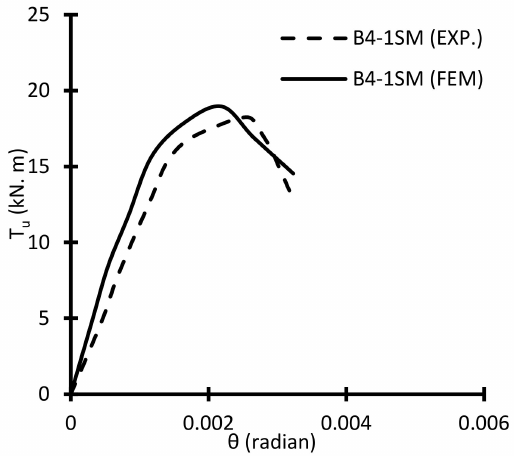
Figure 39. Torque-twist curves of the beam B4-1SM (FEM and